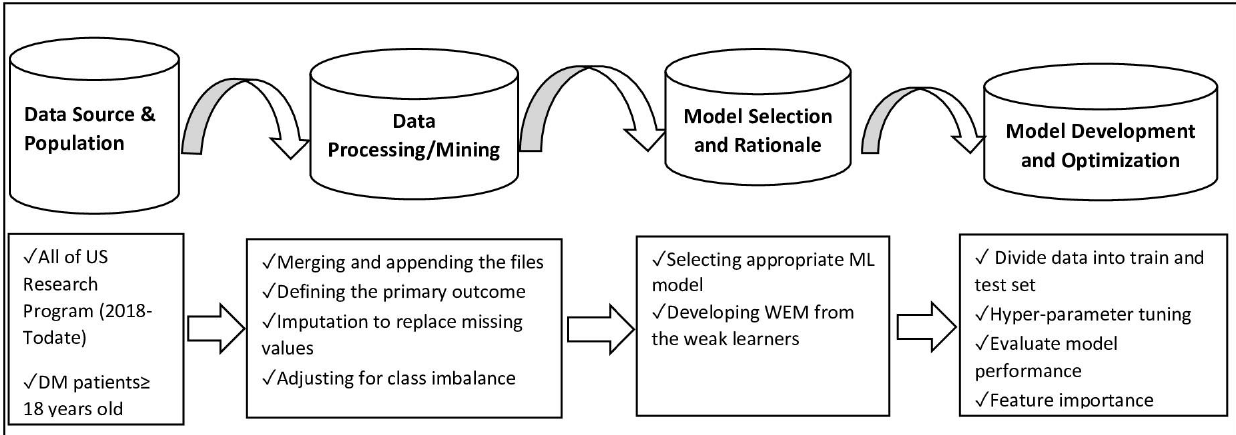
Figure 1. Flow diagram for data processing and machine learning-based model development steps in UDM using AoU Research Program